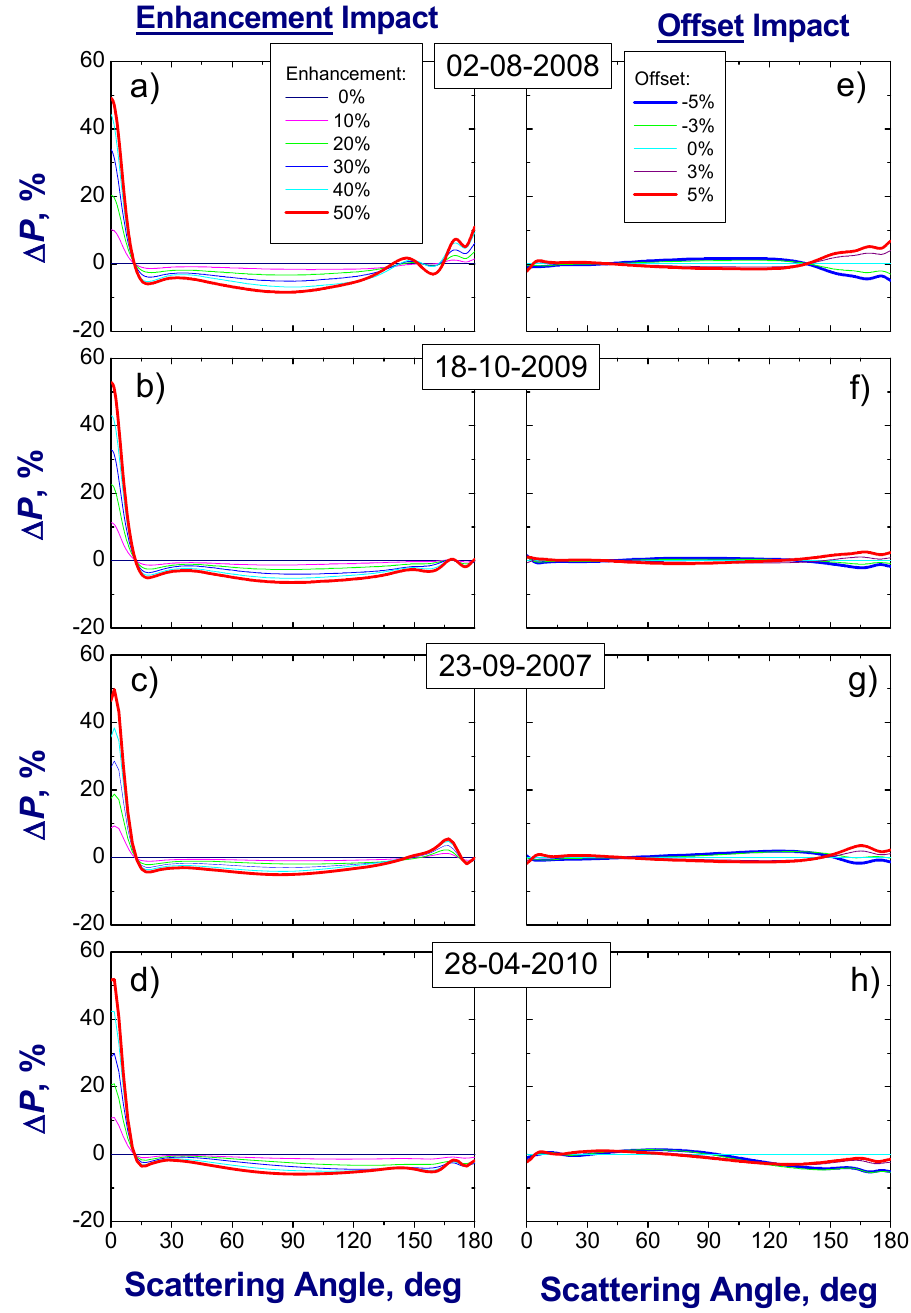
Figure 8. The same as Figure 5, except that these differences correspond to the scattering phase function ( P ) at 1.02 µm